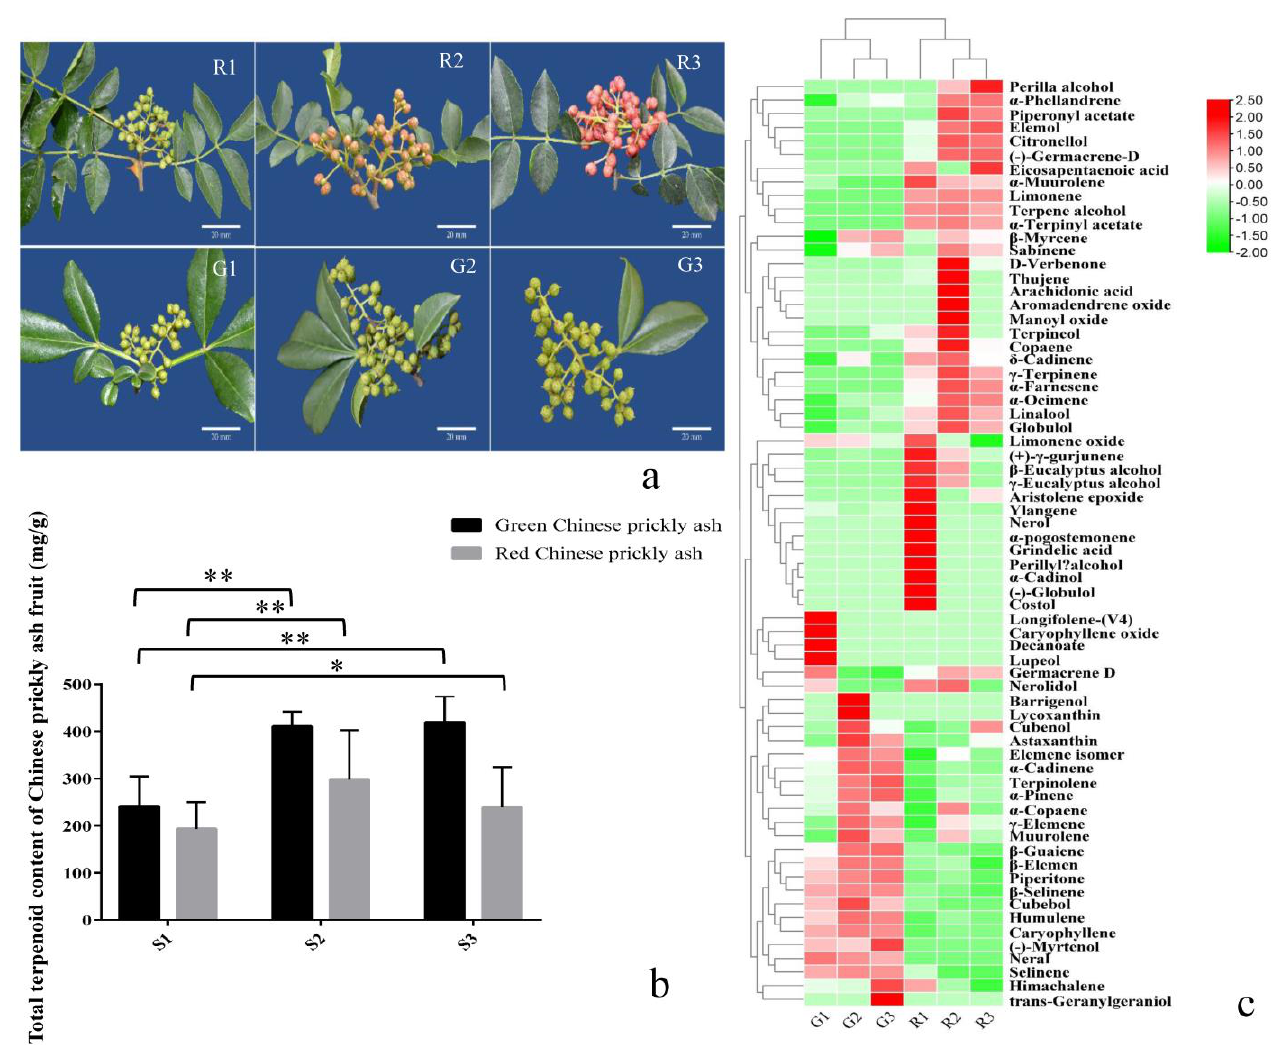
Figure 1. Terpenoid contents of green and red prickly ash fruits at different developmental stages. ( a ) Green and red prickly ash fruits at different developmental stages. The scale bar is 20 mm. ( b ) The total terpenoid content in green and red prickly ash fruits at different developmental stages. * 0.01 < p < 0.05, ** p < 0.01. ( c ) Heat map of individual terpenoid contents in green and red prickly ash fruits at different developmental stages.